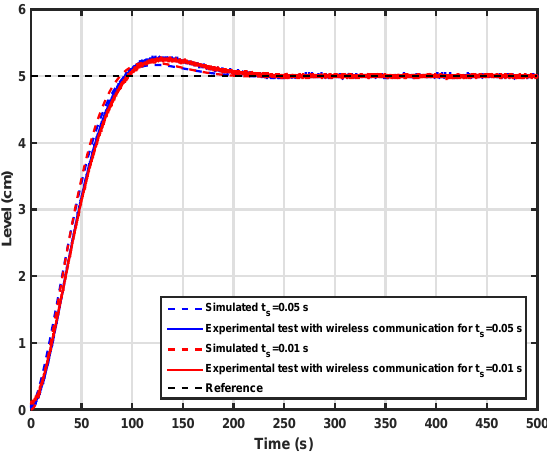
Figure 8. System response for both